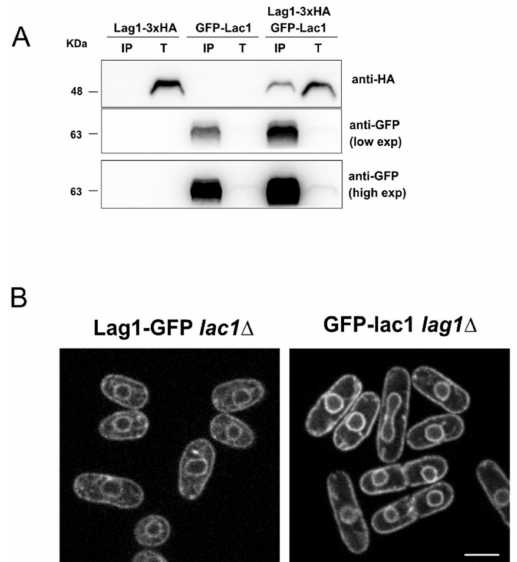
Figure 3. Lac1 and Lag1 co-immunoprecipitate in vivo. ( A ) Wild-type strains expressing GFP- Lac1, Lag1-3xHA or GFP-Lac1 Lag1-3xHA were grown in YES media and immunoprecipitated on ER-enriched fractions with anti-GFP antibody, followed by immunoblotting by using antisera to HA and GFP. Total (T) represents a fraction of the solubilized input material. IP represents total protein immunoprecipitated. Due to the highly efficient immunoprecipitation, image shows different exposure times (low exp/high exp) to demonstrate a band is present in the total extracts. Two biological replicates of the immunoprecipitation were processed, showing the same result. ( B ) Lag1- GFP and GFP-Lac1 localization in lac1 ∆ and lag1 ∆ , respectively. Medial section of spinning-disk images is shown. Scale bar is 5 µ